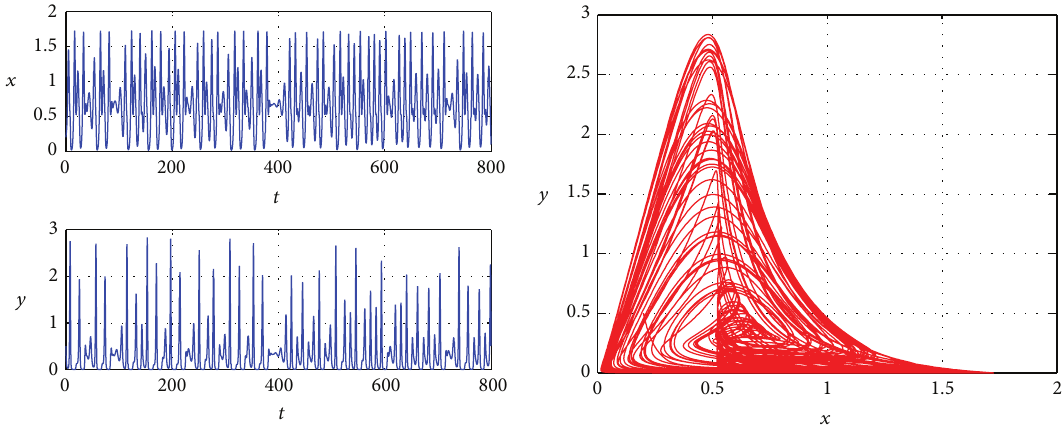
Figure 1: Waveform plot and phase plot of system (2) with 𝜏 = 1.4